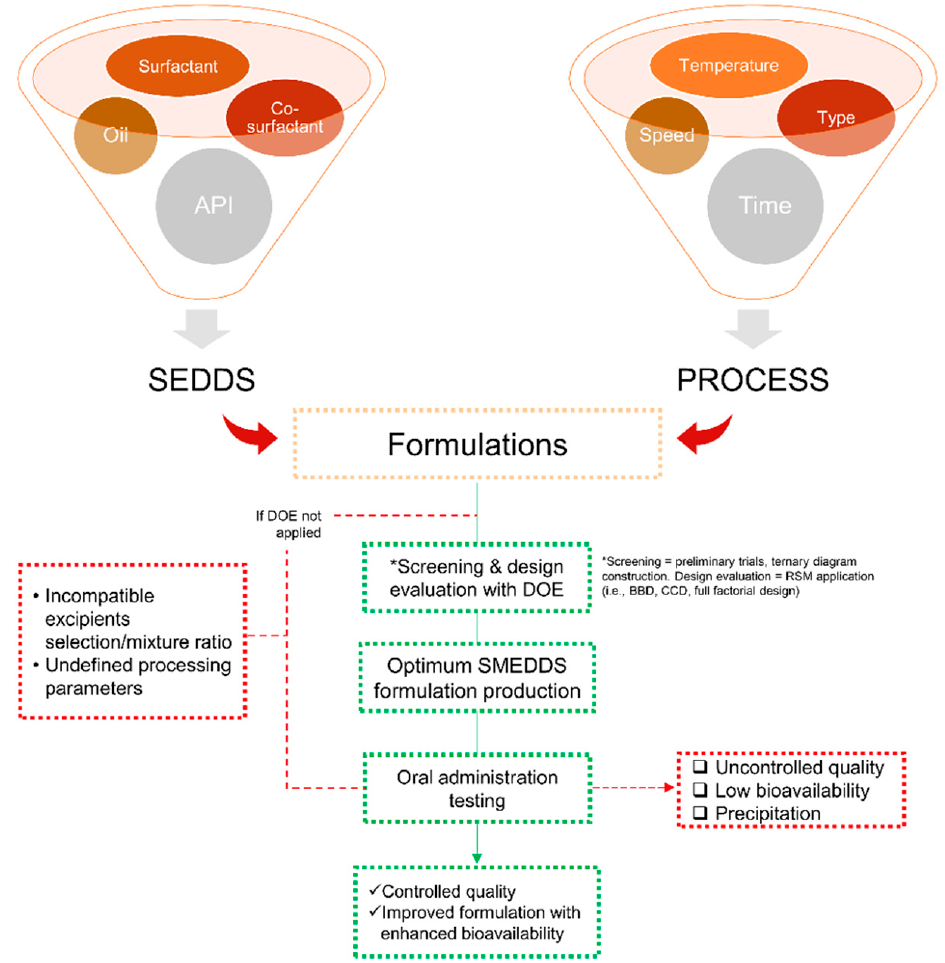
Figure 3. Scheme of the design of experiment (DoE) application in SMEDDS flow-work starting from the selection of materials and processing attributes in a statistical manner to obtain an optimized SMEDDS formulation/parameter. The mentioned abbreviations include self-emulsifying drug delivery (SEDDS), Box-Behnken design (BBD), and central composite design